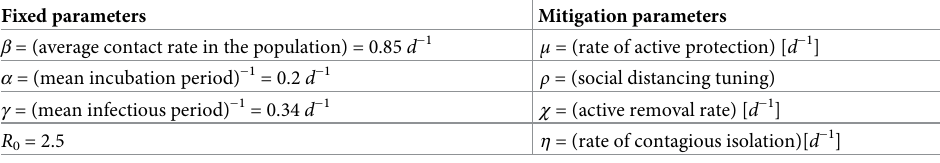
Table 2. SPQEIR model parameters. Fixed parameters Mitigation parameters